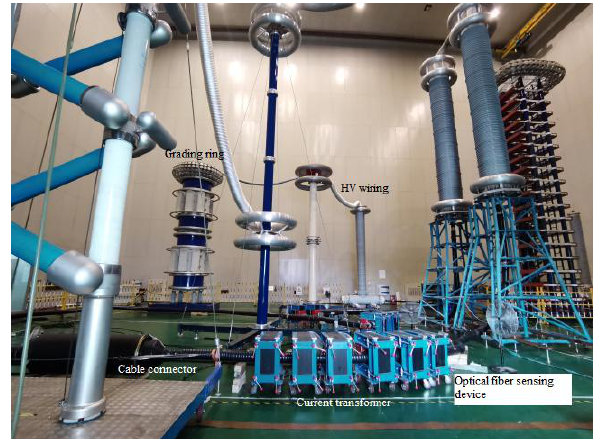
Figure 5. Schematic diagram of partial discharge detection wiring of an XLPE cable.